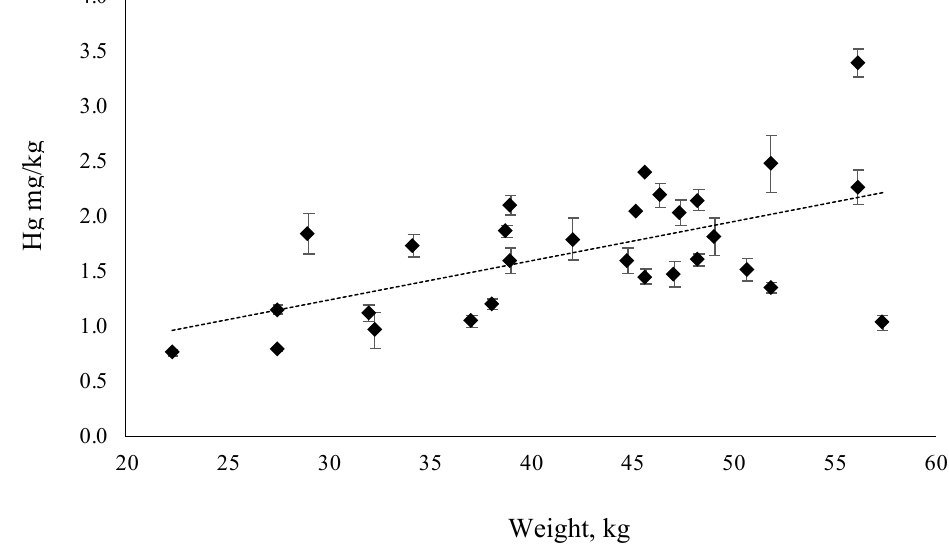
Figure 3. Relationship between Hg concentration (mg/kg w.w.) and body weight (kg) in wild tuna.